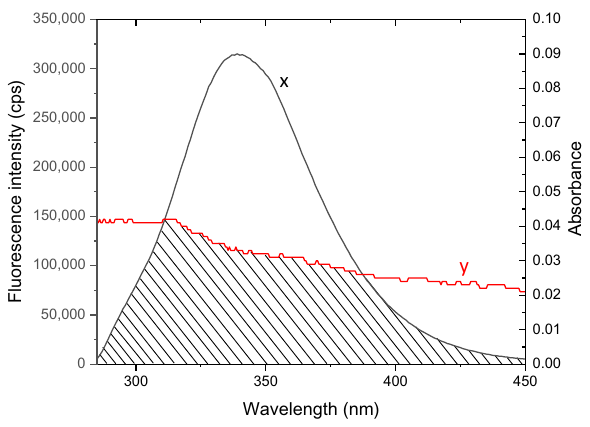
Figure 7. Fluorescence spectrum of BSA (4 µM; x) superimposed with an absorption spectrum of 5A8HQ (5 µM; y). Shade indicates the overlapping area among spectra.